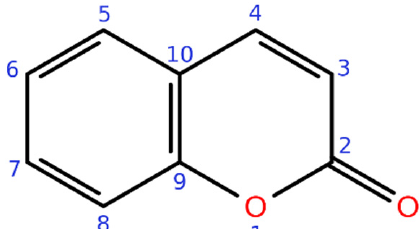
Figure 1. Coumarin. Figure 1. Coumarin.